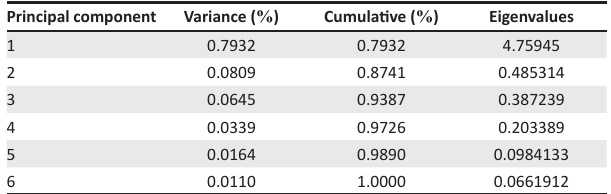
TABLE 2: Extraction method: Principal component analysis.